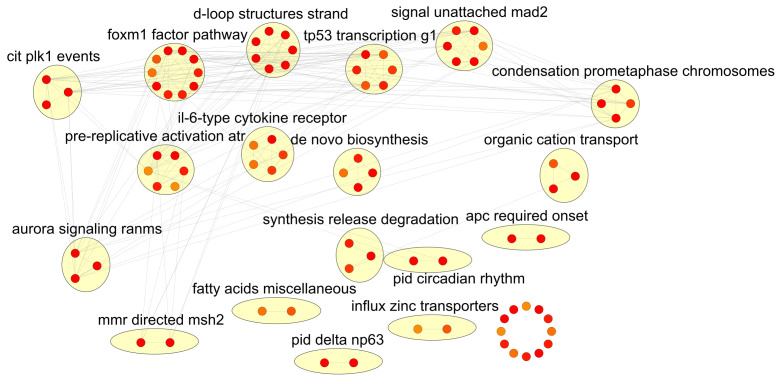
Enrichment map shows consistently high-scoring pathway features when running the breast tumour binary classifier with real-world parameters.This network is generated by running the
plotEmap() function, which uses the
RCy3 Bioconductor package to programmatically call Cytoscape network visualization software from within R, to run the EnrichmentMap app
5–
7. Nodes show pathways features that scored a minimum of 9 out of 10 in feature selection, in at least 70% of train/test splits; node fill indicates feature score. Edges connect pathways with shared genes. The larger yellow bubbles are auto-generated by the AutoAnnotate Cytoscape app
6,
8; these thematically group top pathways, by clustering and word-frequency based cluster annotation.